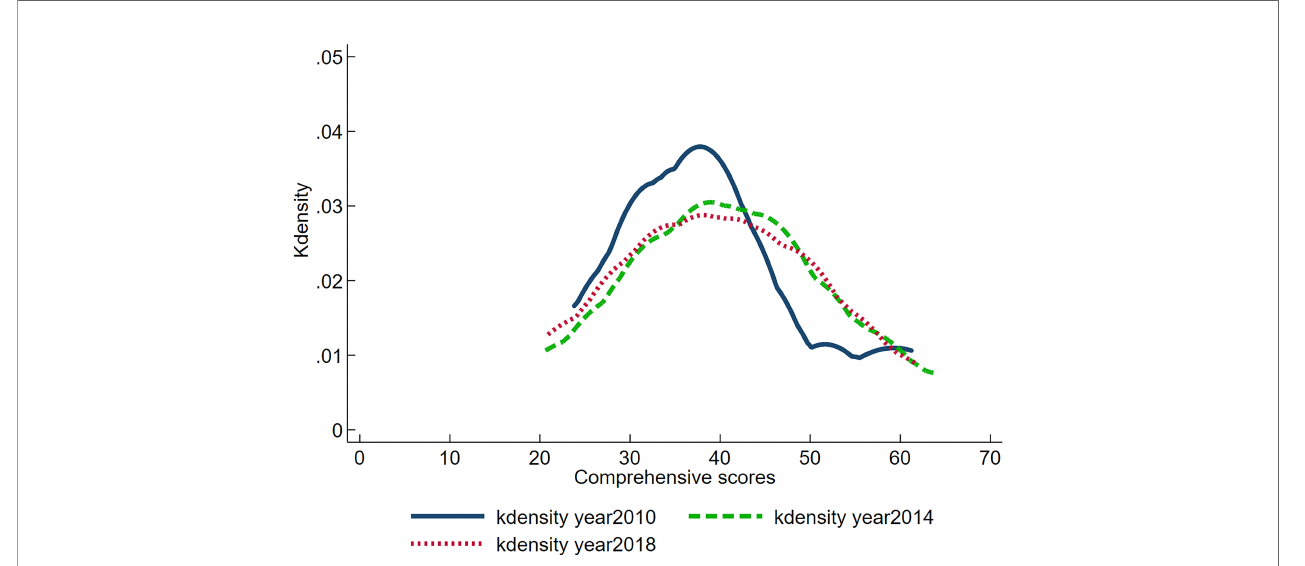
FIGURE 4 | The kernel density curves of the high-quality development level of the marine economy in 11 coastal provinces (cities and